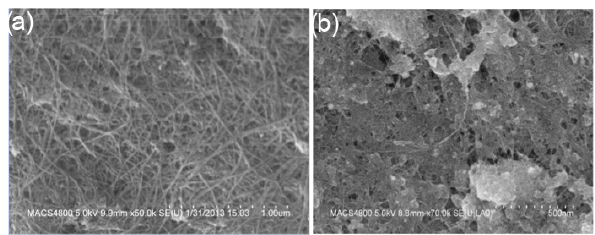
Figure 2. SEM images of (a) pristine and (b) sulfonated single- walled carbon nanotubes.